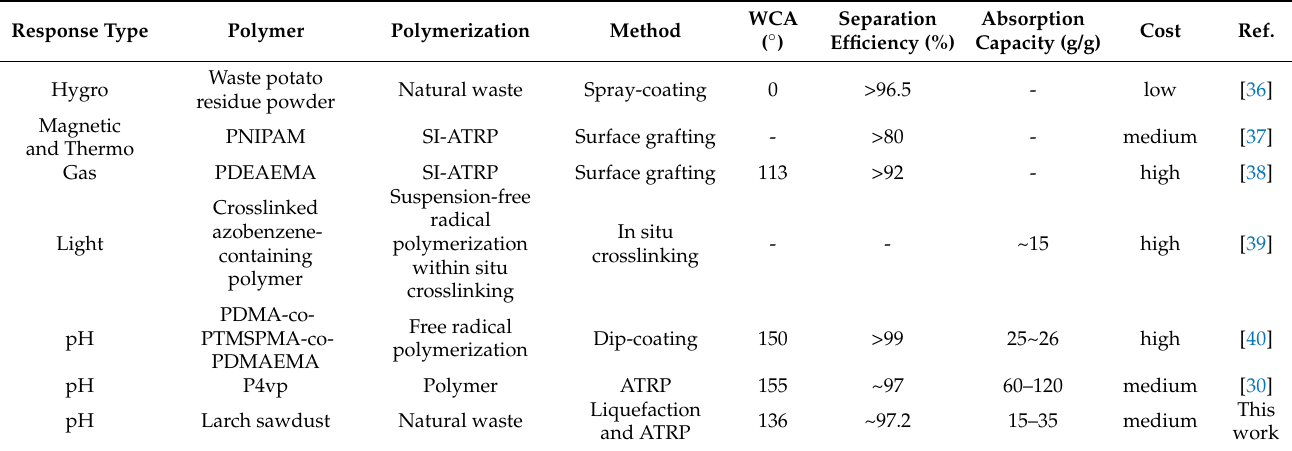
Figure 5. ( a ) Desorption recyclability of pH-responsive CF in pH = 1 water; ( b ) absorption capacity of various oils of pH-responsive CF. Table 1. Comparison of various polymeric absorbents.